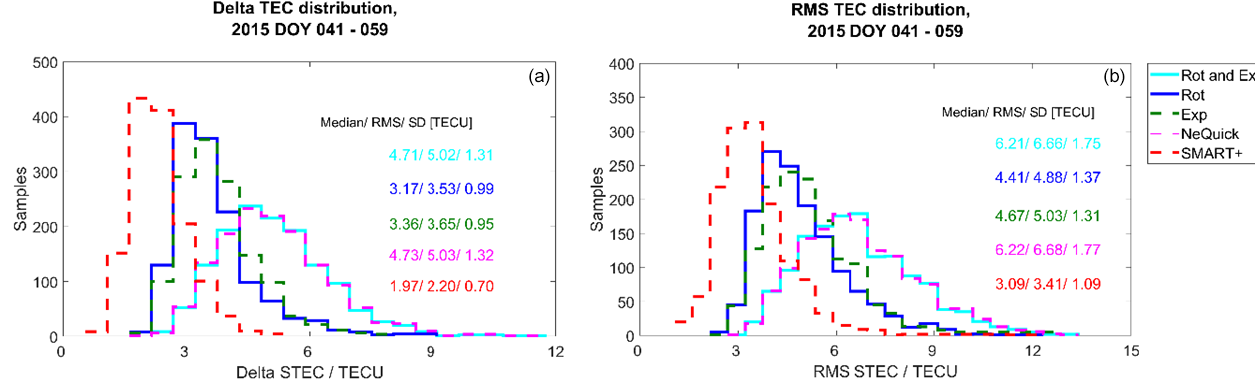
Figure 11. Plausibility check for the quiet period. Distributions of the delta STEC (a) and RMS STEC (b) values.